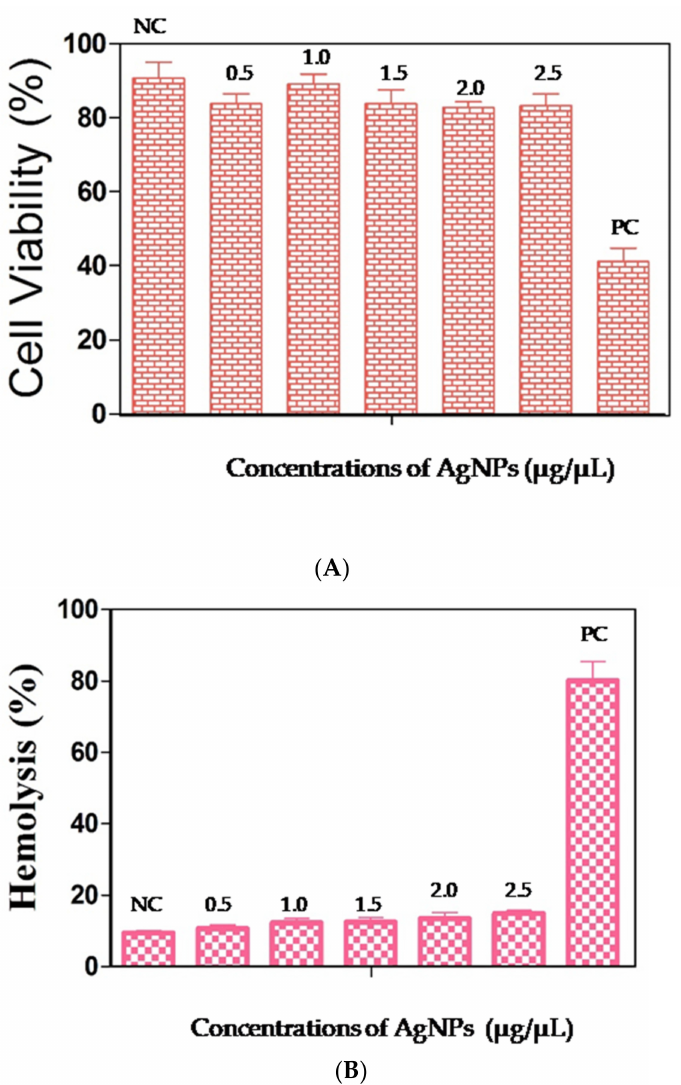
Figure 8. ( A ) Cell viability assay of AgNPs on human platelets. ( B ) Hemolysis assay of AgNPs on human